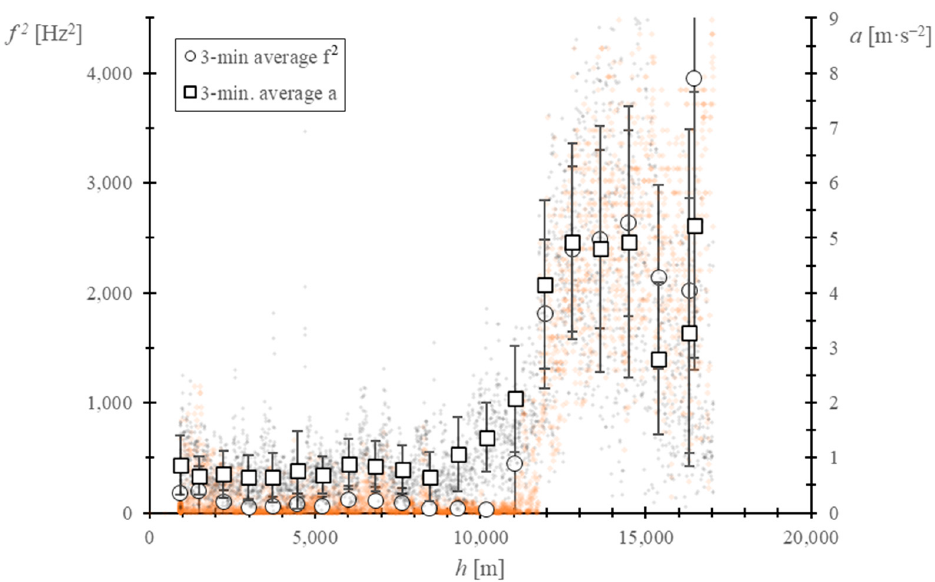
Figure 12. Evolution of the square of the frequency of the anemometer’s output signal and the horizontal acceleration module vs. the altitude of the balloon. The acceleration is calculated with the balloon’s GPS position data. The black dots represent the horizontal acceleration and the orange dots the square of the output signal frequency. The 3-min. average, together with the standard deviation, are shown for both variables.